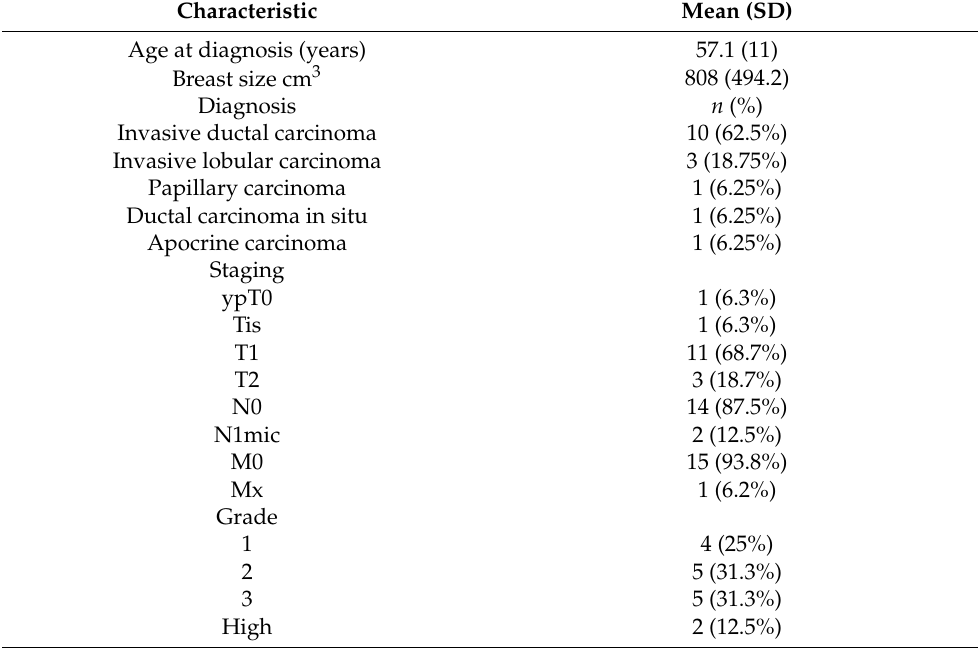
Table 1. Patient characteristics, n =